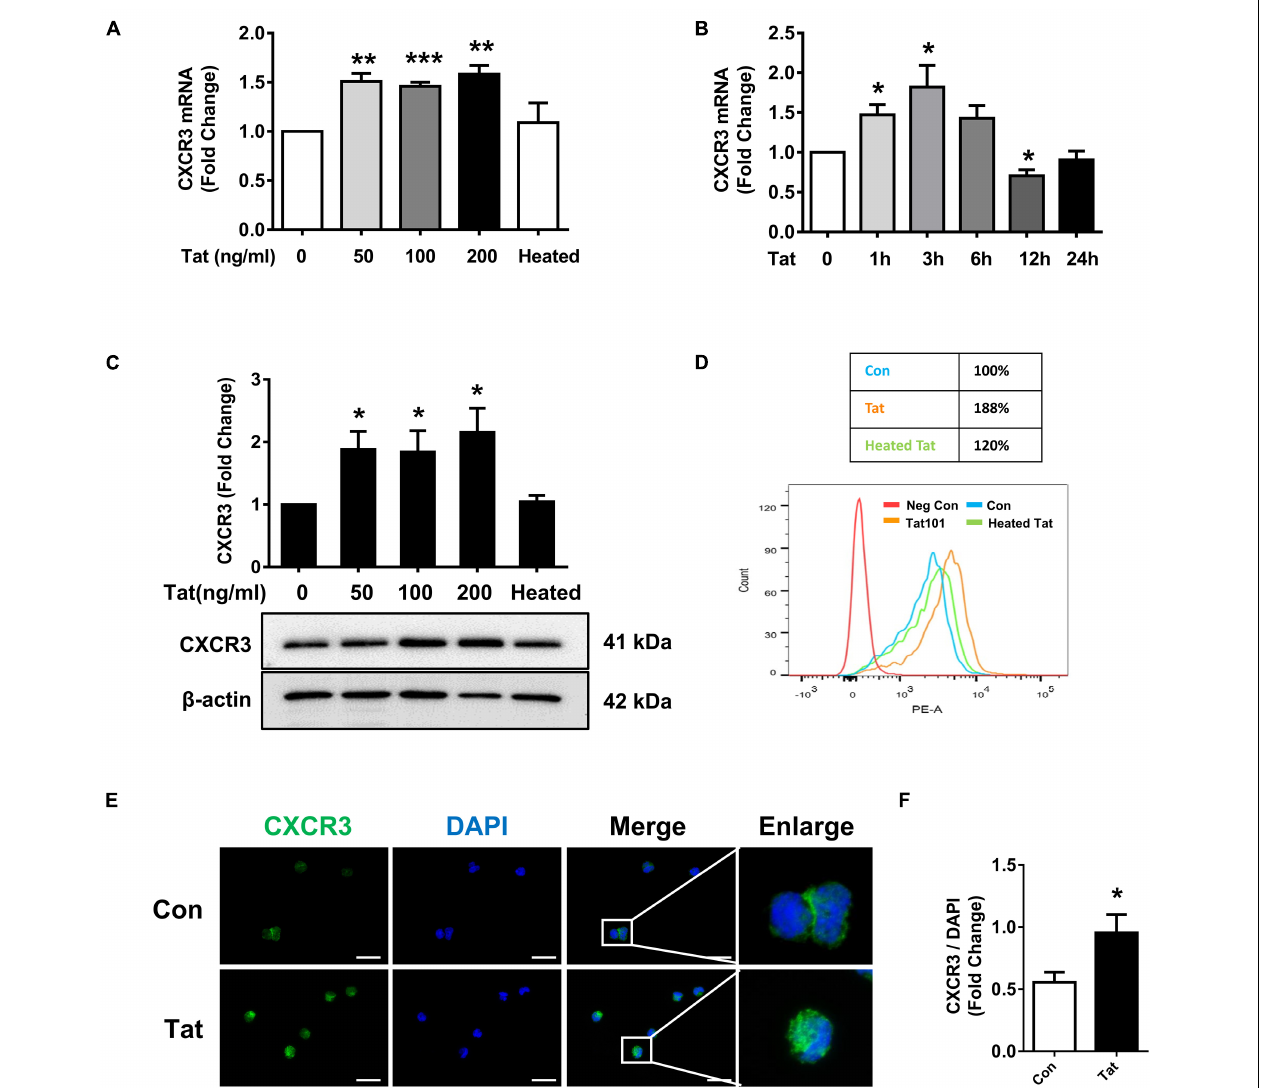
FIGURE 2 | HIV Tat-mediated upregulation of CXCR3 in human monocytes. (A) Real-time PCR analysis of CXCR3 mRNA expression in human monocytes exposed to various concentrations of HIV Tat (50, 100, and 200 ng/ml) and heated HIV Tat (50 ng/ml). N = 3. (B) Real-time PCR analysis of CXCR3 mRNA expression in human monocytes exposed to HIV Tat (50 ng/ml) for varying time points. N = 3. (C) Representative Western blot and quantification of CXCR3 in the cell lysates from human monocytes exposed to various concentrations of HIV Tat (50, 100, and 200 ng/ml) and heated HIV Tat (50 ng/ml). N = 4. (D) Flow cytometry analysis of CXCR3 expression on the human monocytes exposed to HIV Tat and heated HIV Tat (50 ng/ml). (E) Representative images of human monocytes exposed to HIV Tat and stained with anti-CXCR3 antibodies. Scale bar 20 µ m. N = 3. (F) Quantification of fluorescent intensities of CXCR3 staining in human monocytes (Student’s t -test). One-way ANOVA with post hoc test. All data are presented as mean ± SD of three or four individual experiments (Biological replicates). * p < 0.05 versus control group; ** p < 0.01 versus control group; *** p < 0.001 versus control